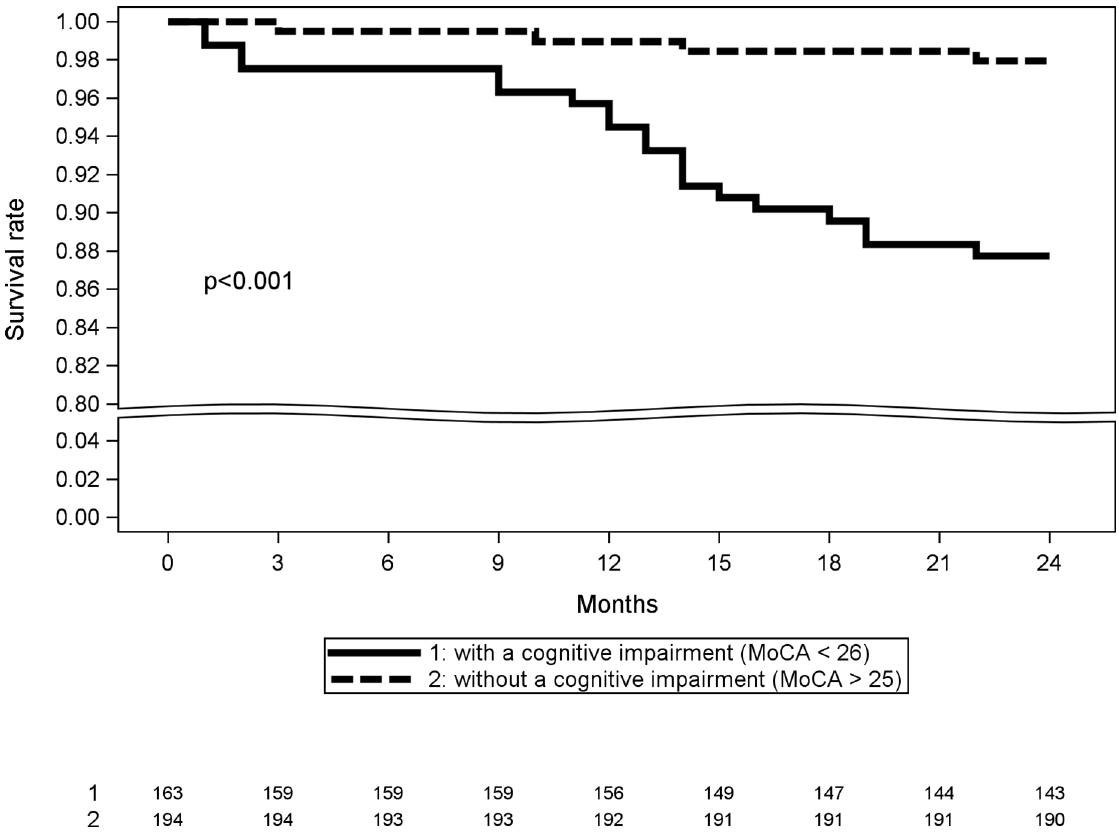
Fig 1. Kaplan-Meir overall survival estimates of two-year overall survival between older patients without a cognitive impairment (MoCA (cid:1) 26; n = 4) and patients with a cognitive impairment (MoCA < 26; n = 20) when treatment for breast, prostate, or colorectal cancer is